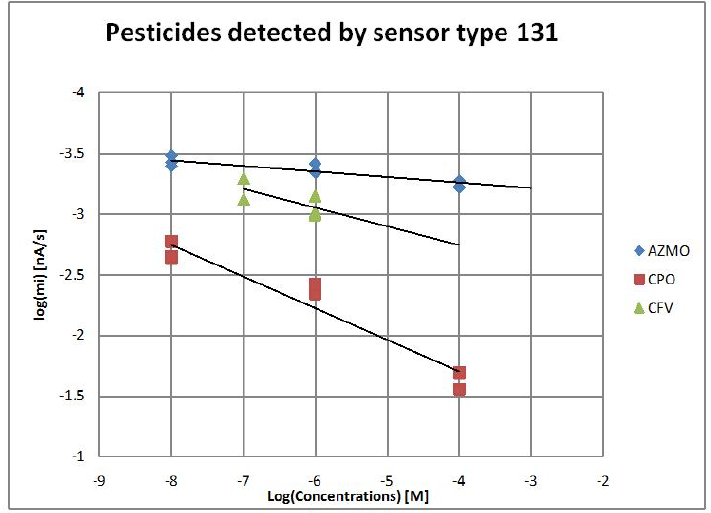
Figure 6. Inhibition response to CPO, CFV and AZMO. Logarithmic dependence of inhibition response.